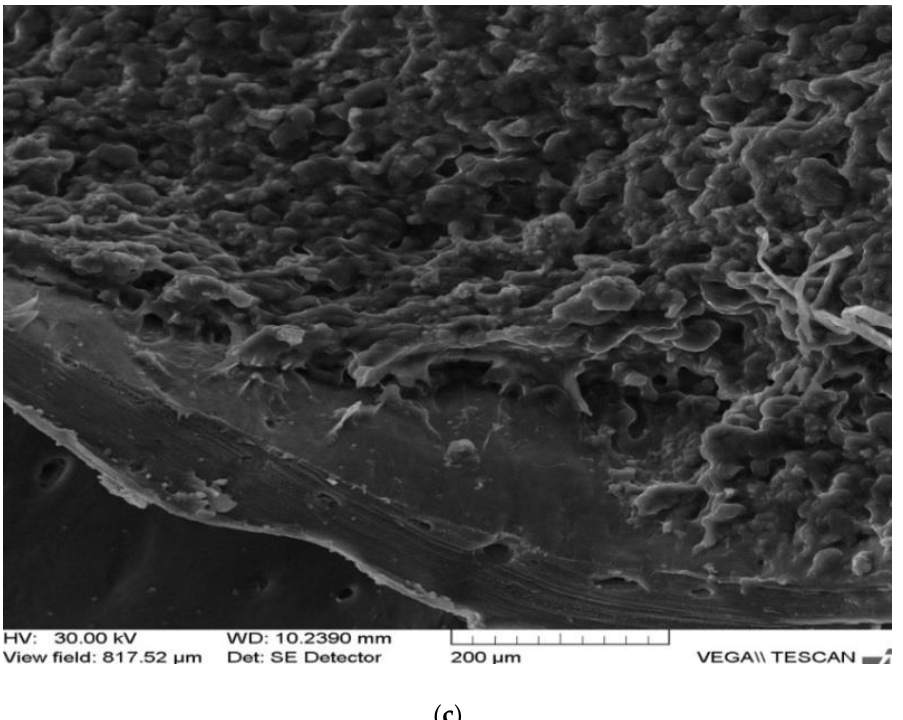
Figure 1. ( a ) Distribution of the patients from Clinical Dental Education Base, “Mihail Kogalniceanu”— Grigore T. Popa University of Medicine and Pharmacy from Iasi, Romania participants in the study. ( b ) Visual Analog Scale used for making score objectivation by patients’ assessment. ( c ) Presence of numerous osteoblasts included in ossein sequestrations, with a tendency to organize in osteoid matrix (Sealapex).